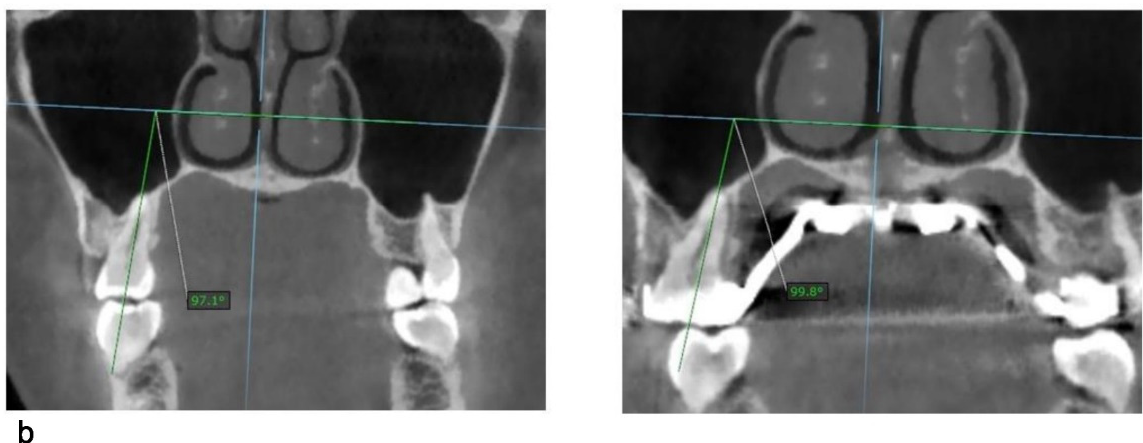
Figure 4. Illustration of measurement of tooth inclination as an angle between tooth axis and the horizontal line for: ( a ) first premolar before expansion ( left ) and after expansion ( right ); ( b ) first molar before expansion ( left ) and after expansion ( right ).